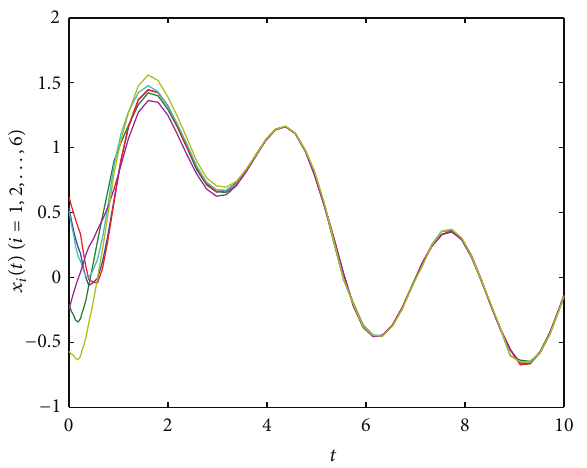
Figure 6: The velocity curves V 𝑖 (𝑡) (𝑖 = 1, 2, . . . , 6) for nonlinear multiagent systems (45) with 𝜏 0 = 0 , 𝜏 1 = 0.3 .